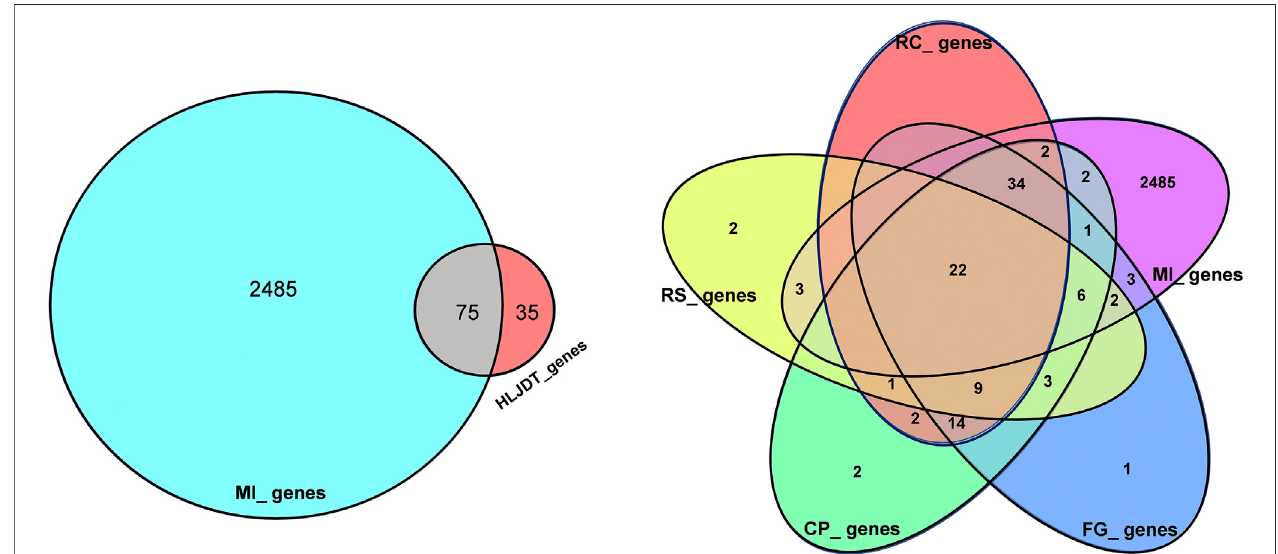
FIGURE 2 | Overlaps between different gene sets. (A) Overlaps between MI diseases genes from HLJDT-related genes; (B) Overlaps between different gene sets from MI and 4 main herbs in HLJDT prescription. RC -Rhizoma coptidis, RS-Radix scutellariae, CP-Cortex phellodendri, FG-Fructus gardenia .